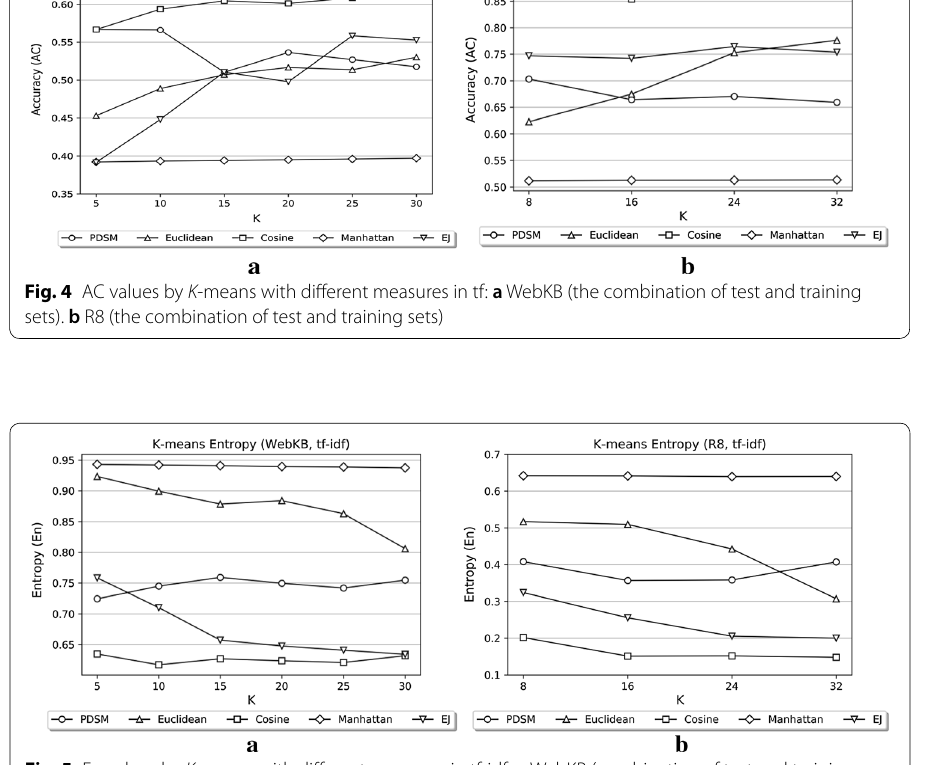
Fig. 5 En values by K -means with different measures in tf-idf: a WebKB (combination of test and training sets). b R8 (combination of test and training